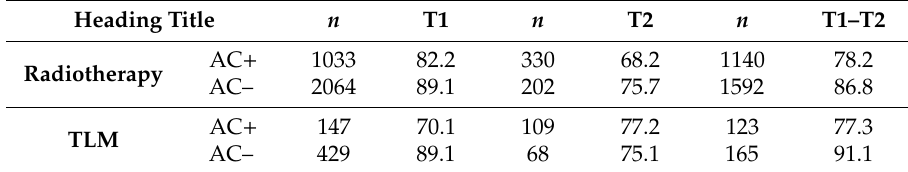
Table 3. Weighted Averages for 5-Year Local Control Classified by Tumor